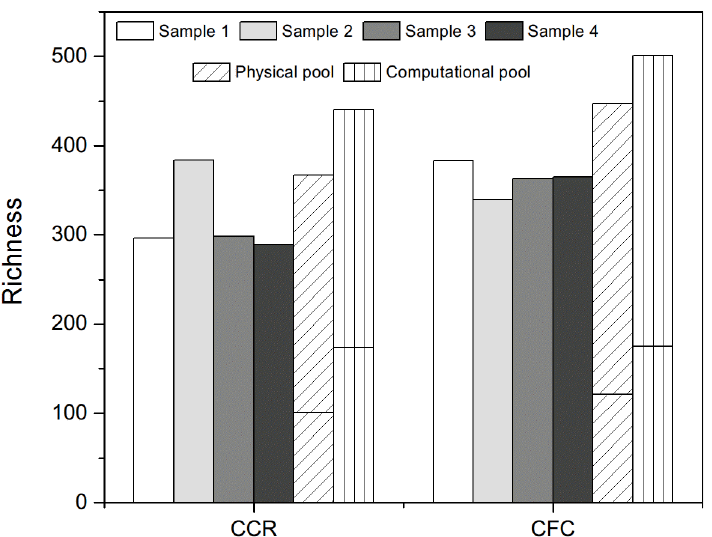
Fig 2. Soil fungal OTU richness of individual samples, physical pool, and computational pool. The shorter bars inside of physical and computational pools indicated the number of unique OTUs that were not shared between the two pools in each site. All samples used 0.25 g soil with standard DNA extraction and PCR